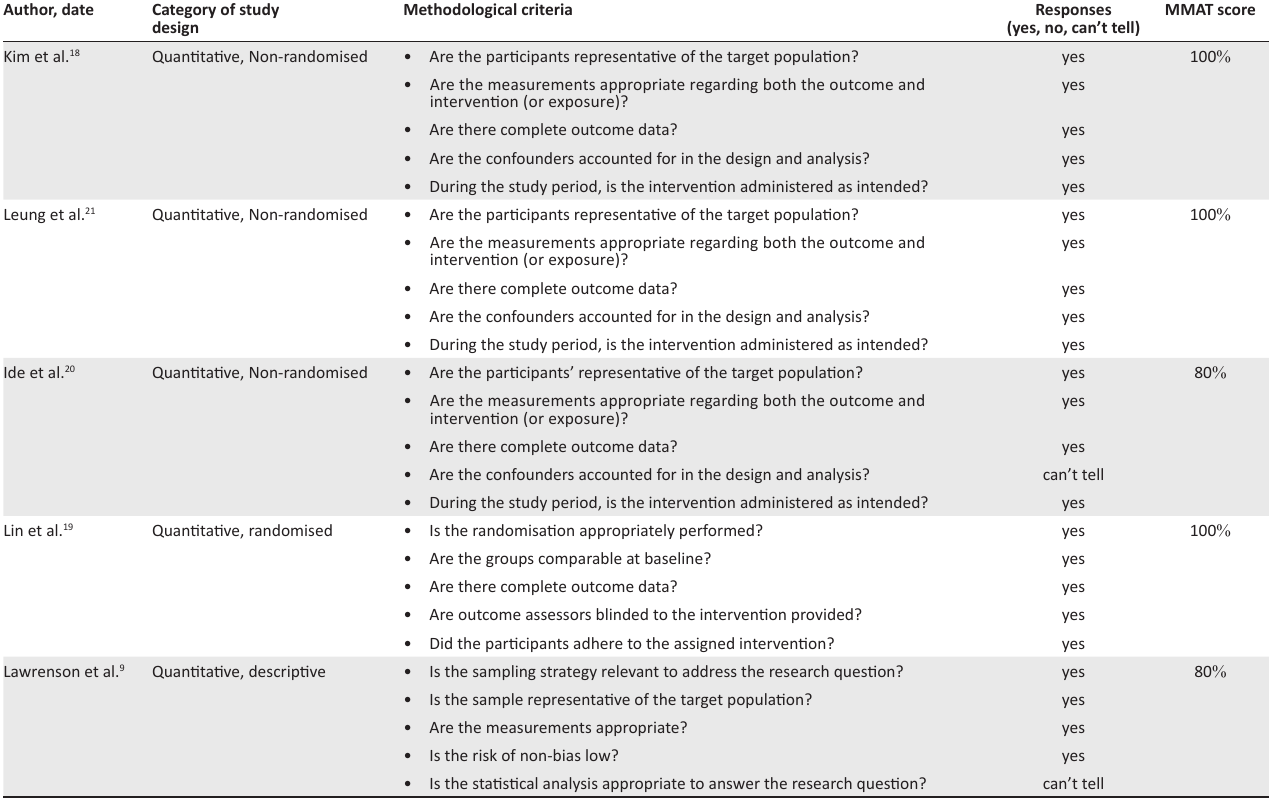
TABLE 3: Quality appraisal of studies included using the mixed method appraisal